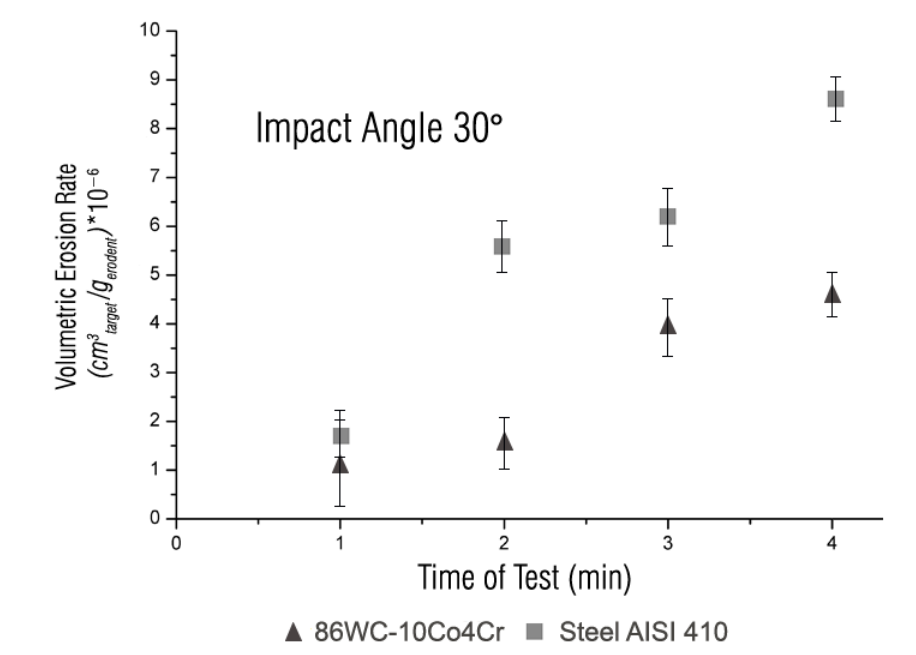
Figure 9. Variation of the accumulated volumetric erosion rate as a function of the impact angle of 30 ◦ for the martensitic stainless steel (AISI 410) and tungsten carbide (86WC-10Co-4Cr)